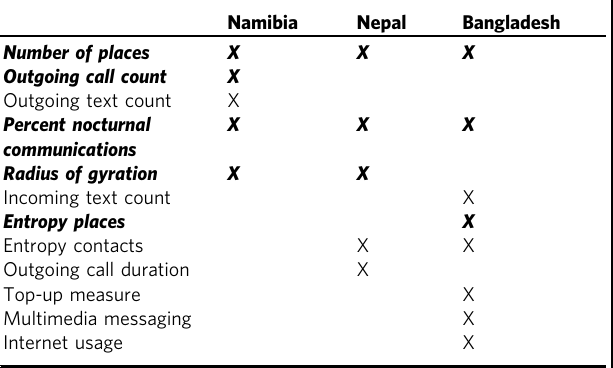
Statistically signi fi cant CDR-derived features for country-level models are denoted with an X. From these, covariates that were statistically signi fi cant in at least one country-level model and available for all three countries make up the CDR data for generalized models, and are italicized in bold.